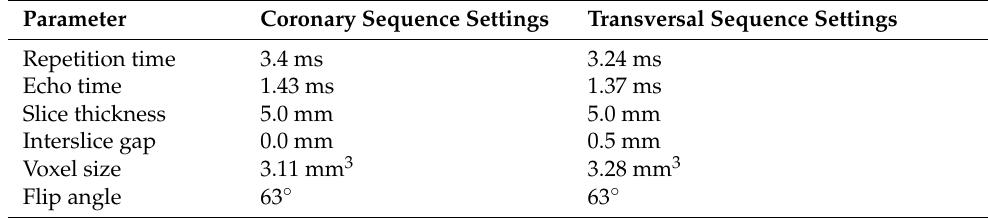
Table 2. T2-weighted TRUFI